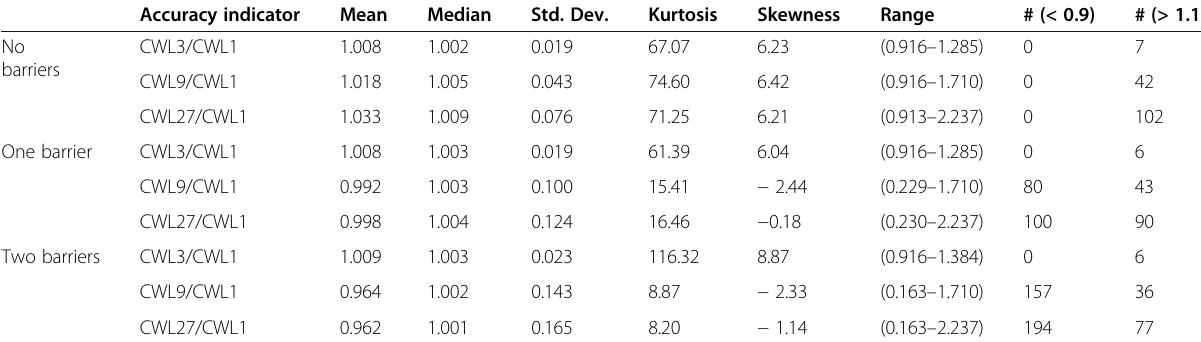
Table 2 Summary statistics of 1000 sample values of CWL3/CWL1, CWL9/CWL1, and CWL27/CWL1 on cost surfaces with no barrier, one barrier, and two